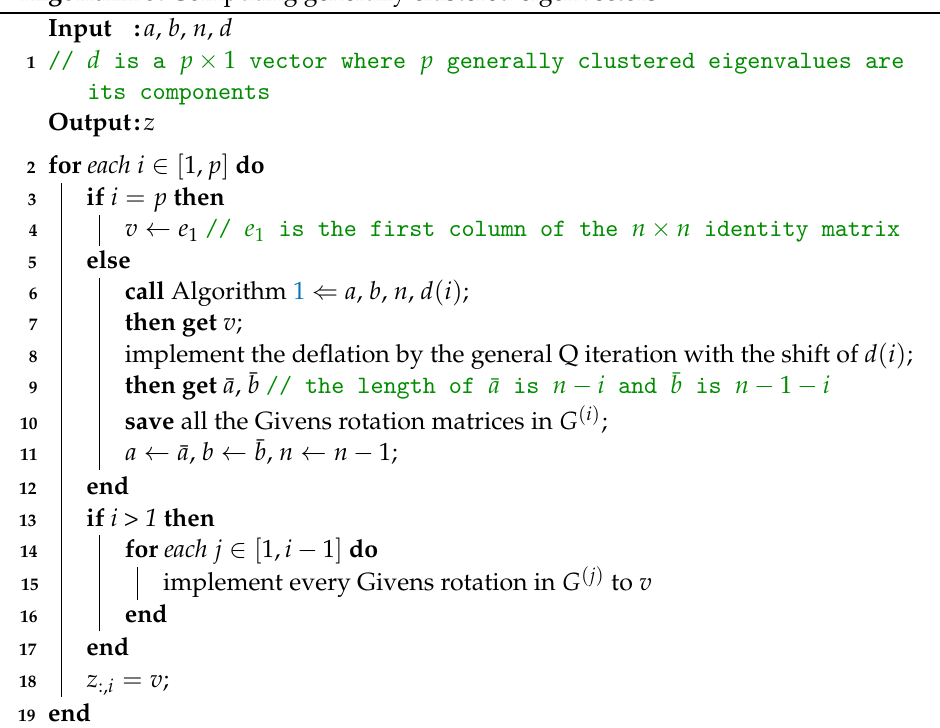
Algorithm 3: Computing generally clustered